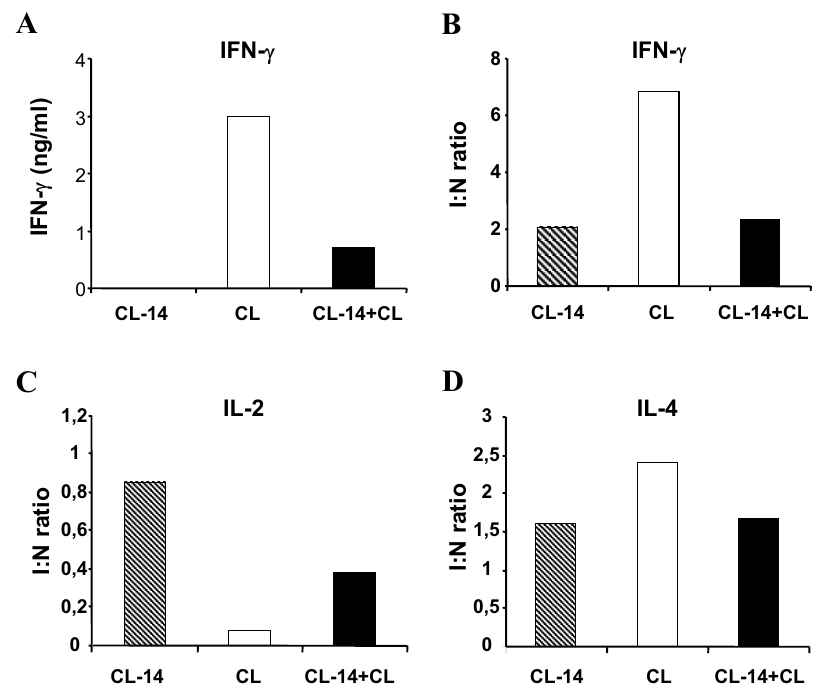
Fig. 1 – Cytokine production in mice inoculated with clone CL-14 and challenged with CL-strain trypomastigotes. Groups of BALB/c mice (non-inoculated controls or mice inoculated 6 weeks before with 10 7 purified CL-14 trypomastigotes) were challenged with 10 4 CL-strain trypomastigotes. Three mice from each group (CL-14 clone or CL strain) were sacrificed two weeks after challenge. Pools of plasma were assayed by ELISA to determine the IFN- γ levels (A). Splenocytes were cultured in 24 well plates and stimulated with ConA ( 1 µ g/ml ) , as described in Material and Methods. Cell-free supernatants were collected after 24hs of incubation and assayed to determine the IFN- γ (B), IL-2 (C) and IL-4 (D) levels by ELISA. The data represent the ratio between cytokine levels of splenocyte cultures from T. cruzi inoculated mice (10 7 CL-14 clone: dashed bars; CL strain: open bars; CL strain after inoculation with CL-14 clone: black bars) and the levels of splenocyte cultures from normal mice, upon stimulation with Con A. Figure shows the results of one representative experiment of three